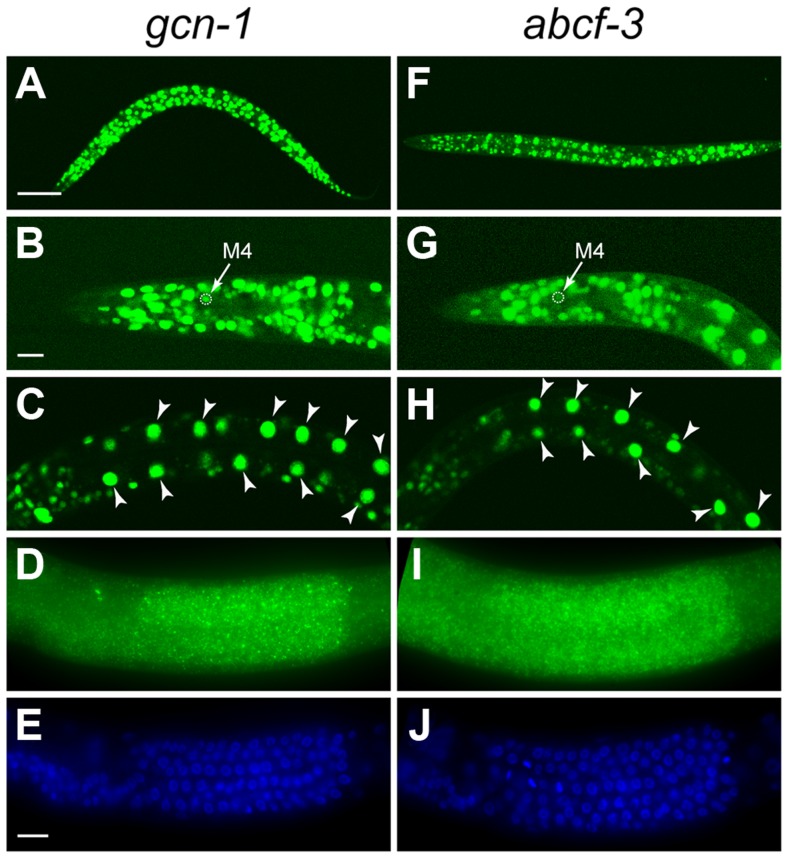

gcn-1 and abcf-3 are ubiquitously expressed.(A–E) Expression pattern of gcn-1. (A–C) Expression of GFP under the control of the gcn-1 promoter in second-larval stage animals and (D and E) FISH of gcn-1 mRNA in third-larval stage animals. Green, gcn-1 mRNA. Blue, DAPI staining of nuclei. (F–J) Expression pattern of abcf-3. (F–H) Expression of GFP under the control of the abcf-3 promoter in the second-larval stage animals and (I and J) FISH of abcf-3 mRNA in third-larval stage animals. Green, abcf-1 mRNA. Blue, DAPI staining of nuclei. Arrows, M4 neuron. Arrowheads, intestinal cells. Scale bars, 50 µm in A and F; 10 µm in B, C, G, H; and 5 µm in D, E, I and J.